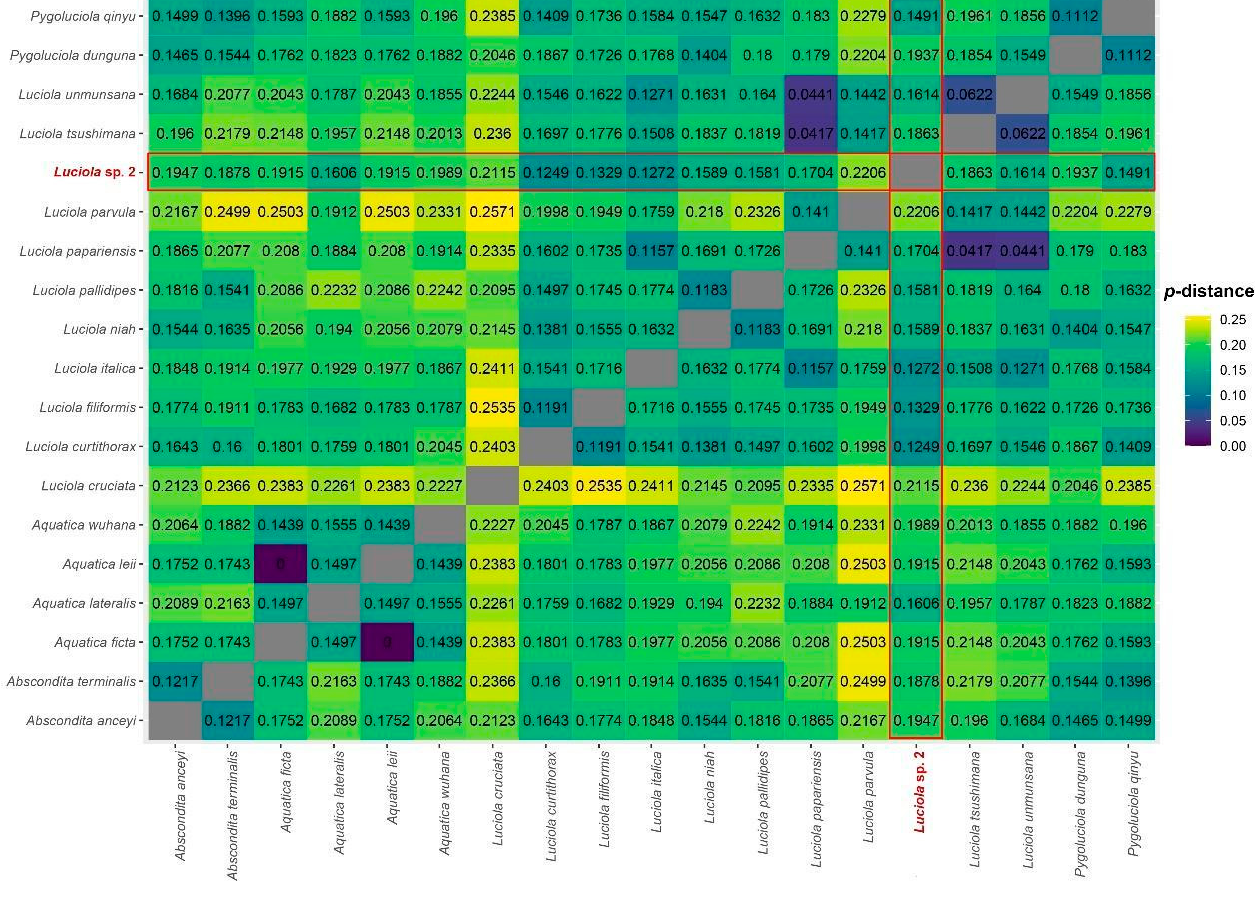
Figure 2. Heatmap of uncorrected p -distances among Luciola sp. 2 and closely-related taxa based on COX1